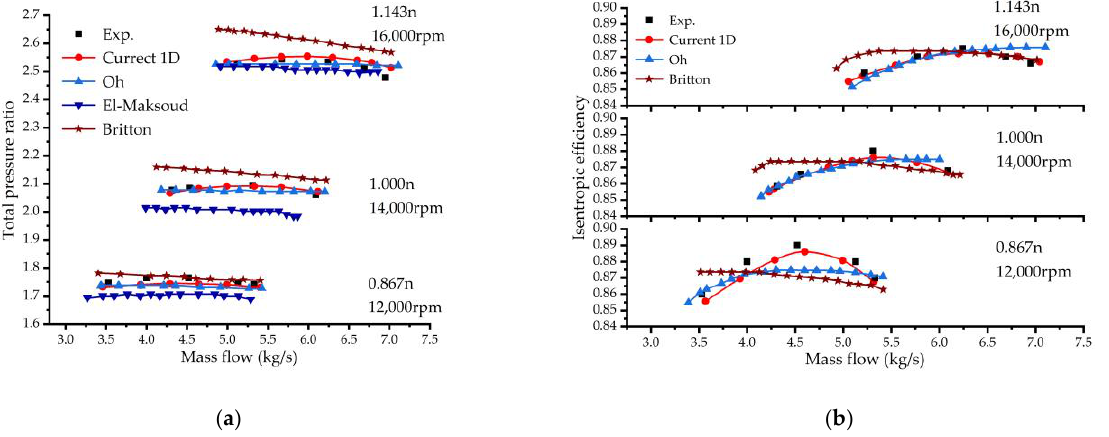
Figure 13. Comparisons of different 1D prediction for the Eckardt-O impeller: ( a ) Total pressure ratio; ( b ) Isentropic efficiency.